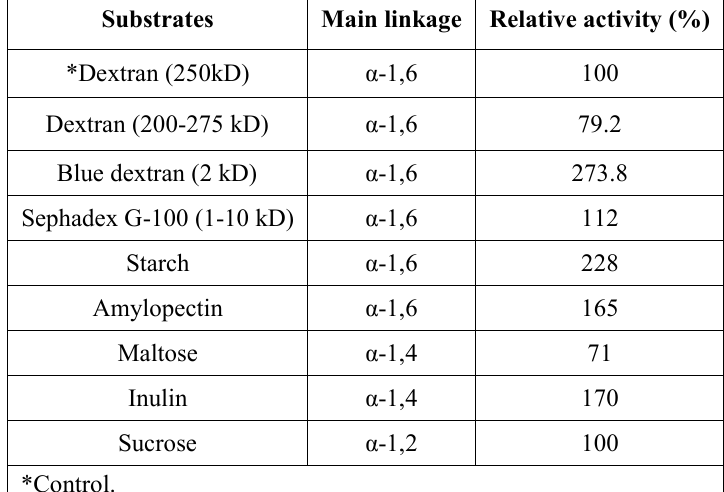
Table 4. Action of Bacillus subtilis NRC-B233b dextranase on various carbohydrates.